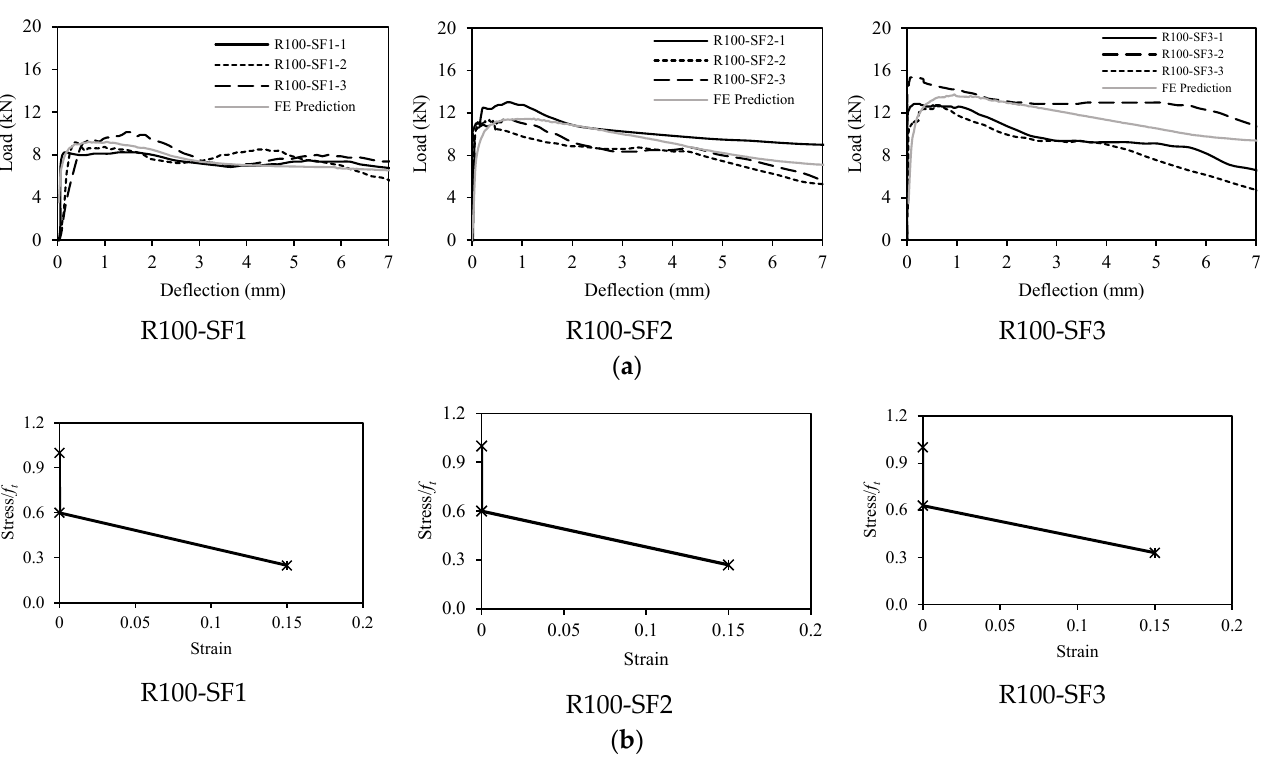
Figure 4. Four-point bending test data: ( a ) load–deflection response; ( b ) tension functions.